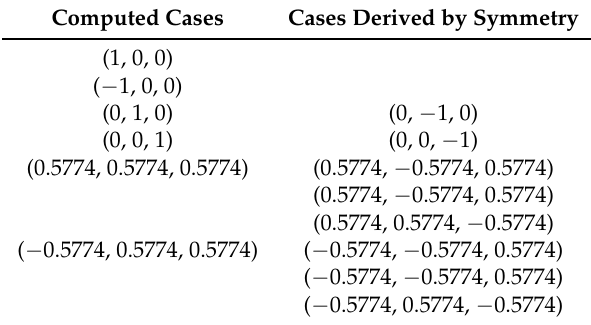
Figure 9. Computational domain with the body-fitted coordinate system. Table 3. List of the computed CFD cases for DB1, the cases being given by the versor of the relative velocity in the body-fitted coordinate system.